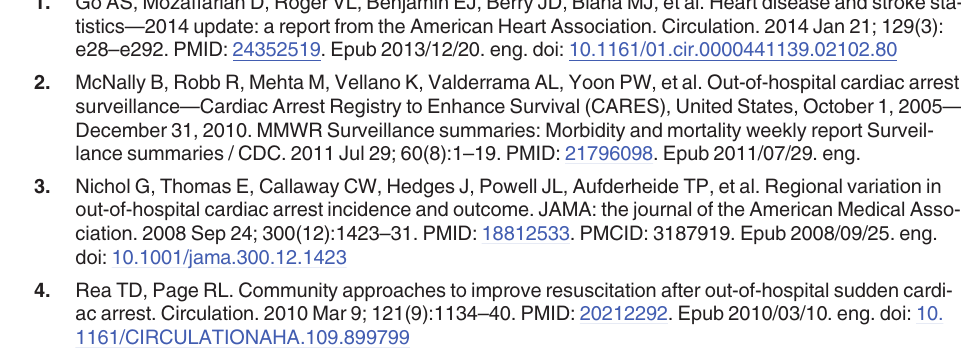
S1 Fig. Locomotor activity following Sham or ACA procedure. Average distance traveled per animal in one 30 minute trial in an open field chamber. Sham animals traveled an average dis- tance of 1943 ± 100.2 cm compared to ACA animals which traveled 1644 ± 212.4 cm (p > 0.05) (Sham n = 6 ACA n = 6). S1 Table. Search Strategy Analysis. Two separate analyses were run. The first analysis divided search strategies into spatial (Sp), or non-spatial (Non) strategies. ACA rats used a spatial less often than sham rats (Chi-Square, (cid:1) p < 0.05). The second analysis divided search strategies into a non-random systematic (sys) (serial + spatial), or random (ran) strategies. ACA rats used a non- random systematic strategy less frequently than sham rats (Chi-Square, (cid:1)(cid:1)(cid:1) p < 0.005). Sp = spatial, non = non-spatial (serial + random), Sys = systematic (serial + spatial), ran = random. (cid:1) = p < .05, (cid:1)(cid:1) = p <